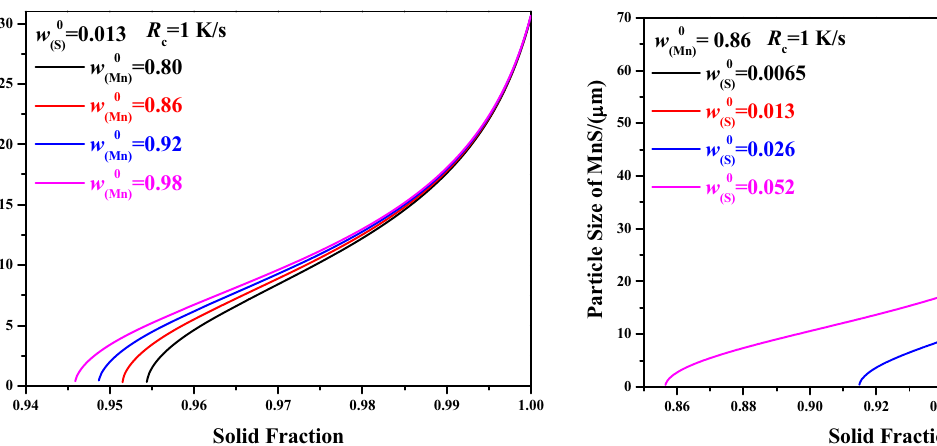
Figure 5: Effect of S concentration on the particle size of MnS